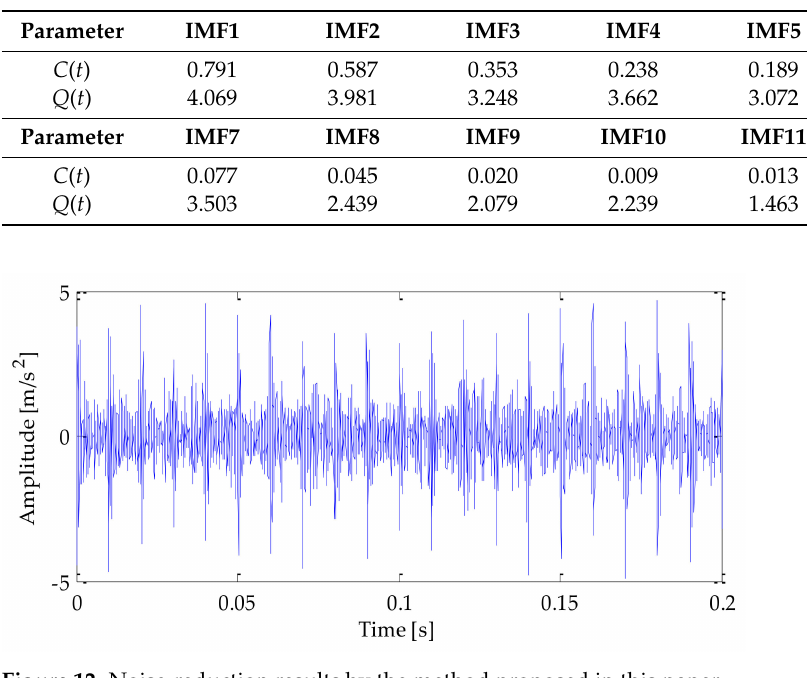
Figure 12. Noise-reduction results by the method proposed in this paper.